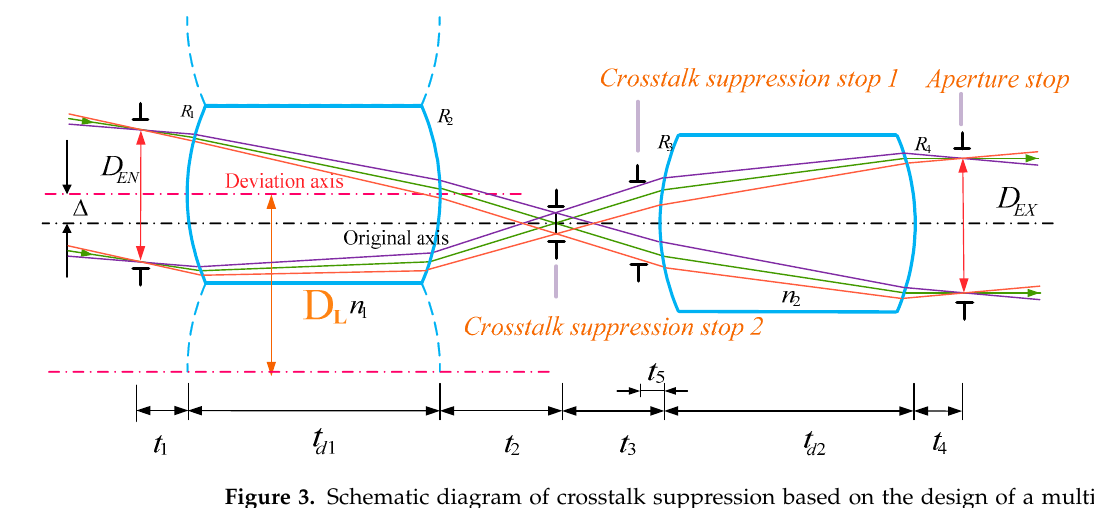
Figure 3. Schematic diagram of crosstalk suppression based on the design of a multilayer array (green: SFOV, red: SFOV+IFOV, purple: SFOV-IFOV).